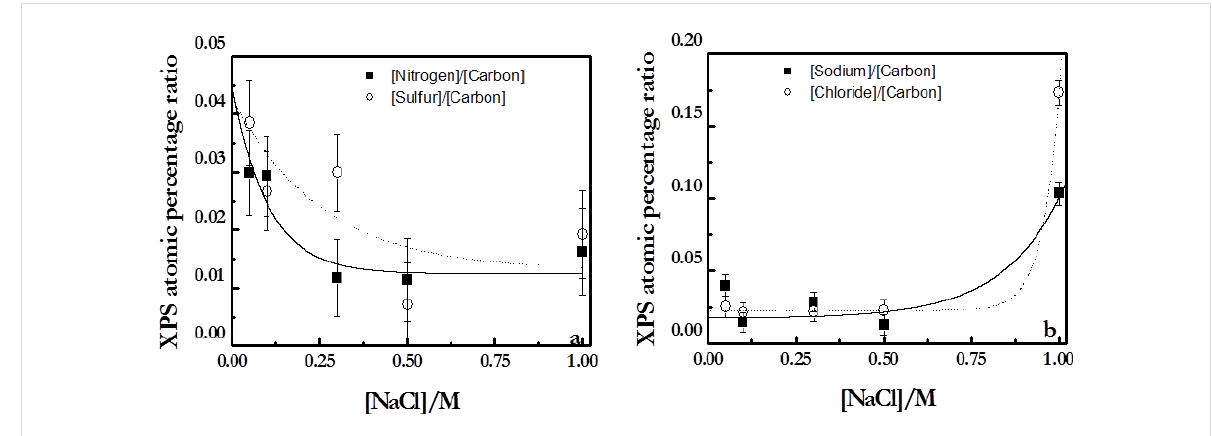
Figure 7: Atomic ratios obtained from XPS measurements at an angle of electron emission of 0°. (a) Ratios of [nitrogen]/[carbon] and [sulfur]/[carbon]. (b) Ratios [sodium]/[carbon] and [chloride]/[carbon]. The solid line is to guide the eye.